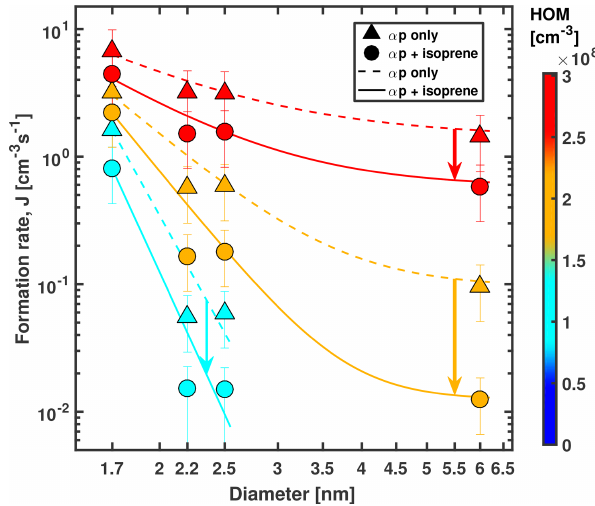
Figure 4. Formation rate (gcr) vs. diameter of particles at + 25 ◦ C and 38% RH. Triangles represent α -pinene only, and circles repre- sent α -pinene + isoprene conditions. α -Pinene levels were 456, 771 and 1442pptv for triangles and 677, 1326 and 2636pptv for circles. Ozone levels were 49ppbv for triangles and 38 to 40ppbv for cir- cles. Isoprene levels ranged from 2.7 to 9.8ppbv for circles. Colour code represents HOM concentration. Bars indicate overall scale un- certainty for formation rates of ± 47%. The uncertainty in the diam- eters is ± 0 . 3nm. Dashed and solid lines are lines to guide the eye. The steeper slope at lower-diameter values is caused by the Kelvin effect, i.e. a smaller growth rate at small sizes that leads to higher losses of newly formed particles. The formation rate measurements at 2.2 and 2.5nm for the lowest α -pinene–isoprene setting (cyan circles) are upper